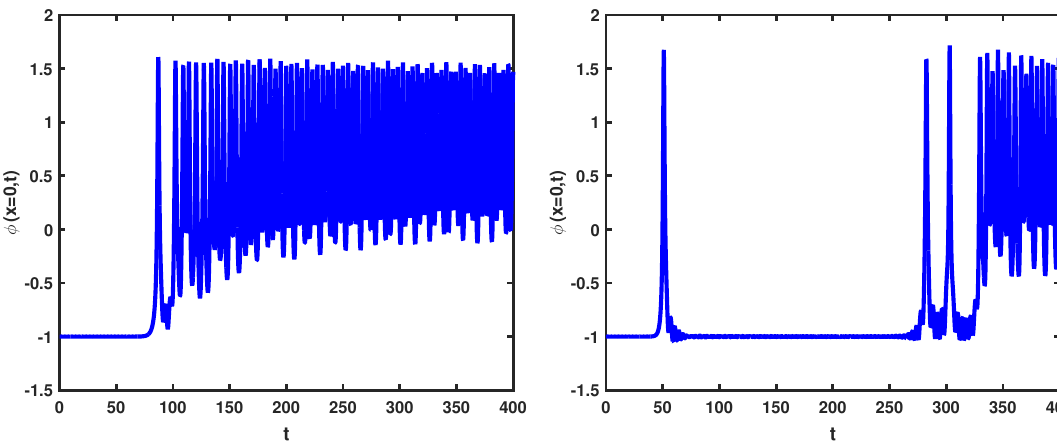
Figure 6 . False vacuum in a bounded interval: antikink-kink collision. Scalar (cid:12)eld at the center of mass, (cid:30) (0 ; t ) as a function of time for (cid:15) = 0 : 001 with (a) v = 0 : 1 and (b) v = 0 : 25, corresponding to (cid:12)gures